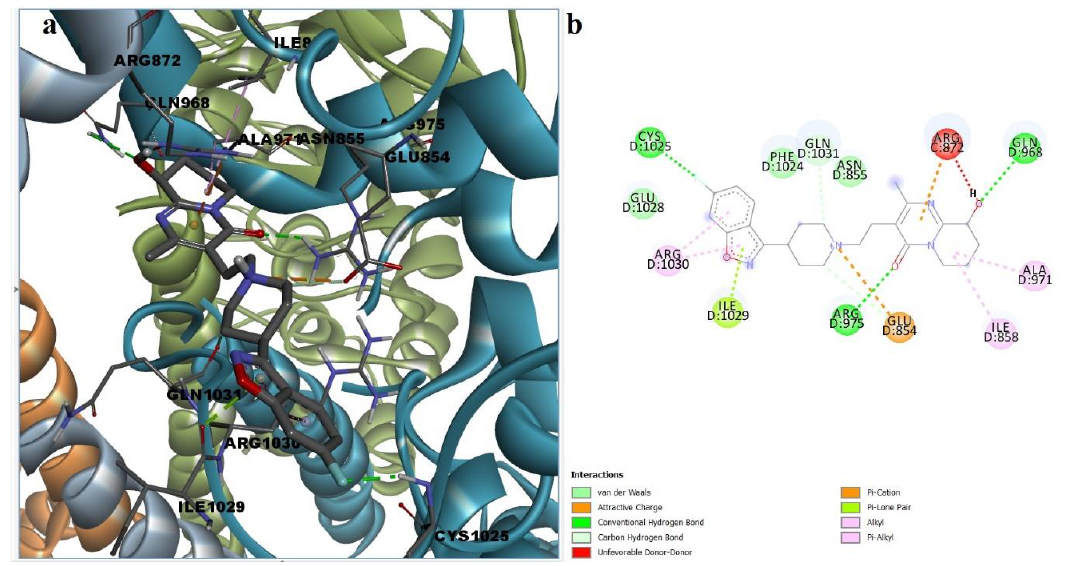
Figure 9. ( a ) 3D binding conformation of paliperidone into putative HC-030031 binding site; ( b ) 2D diagram of protein - ligand interactions between TRPA1 and paliperidone.